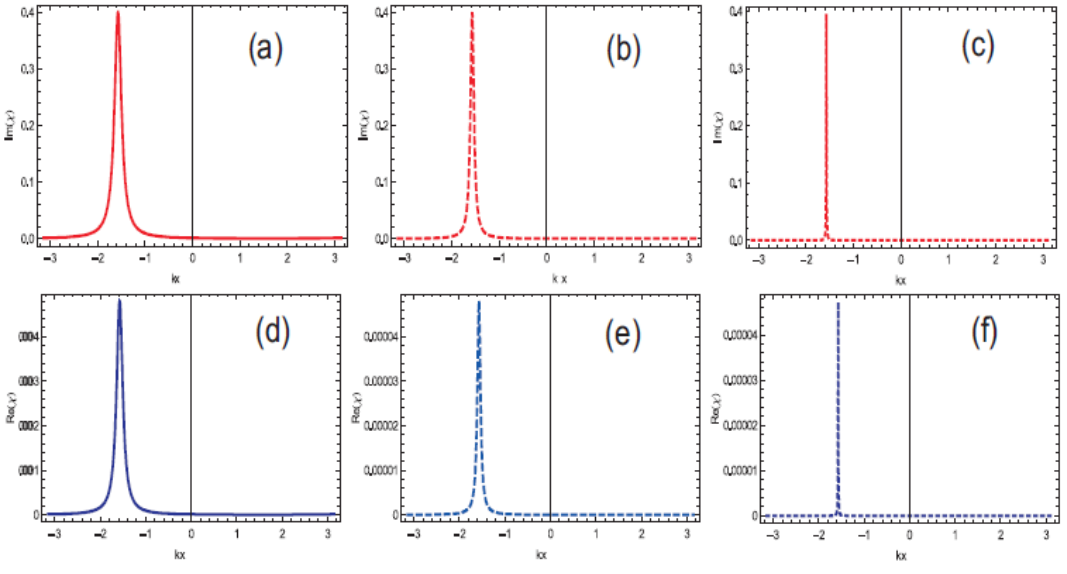
Figure 3. Localization of atom vs kx at the parameters γ = 1 GHz , | Ω 1,2,3 | = R = 50 γ [ a , d ] ,100 γ [ b , e ] ,1000 γ [ c , f ] , γ 1,2 = 1 γ , γ 3 = 0 γ , η 1,3 = 0.5, η 2 = − 0.5, ϕ = π